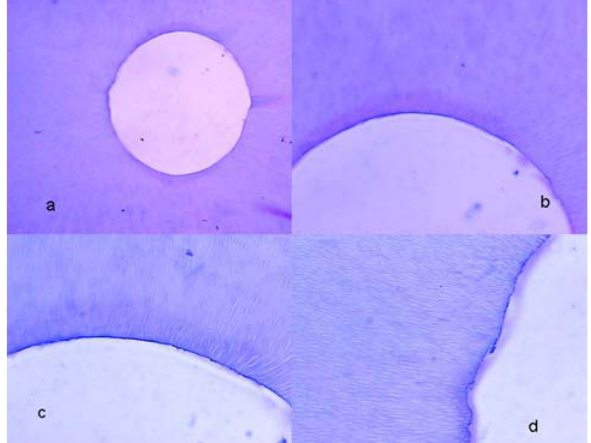
FIGURE 4- Group IV- F1 instrument associated with distilled water irrigation (HE, a-40x; b-100x; c and d-200x)